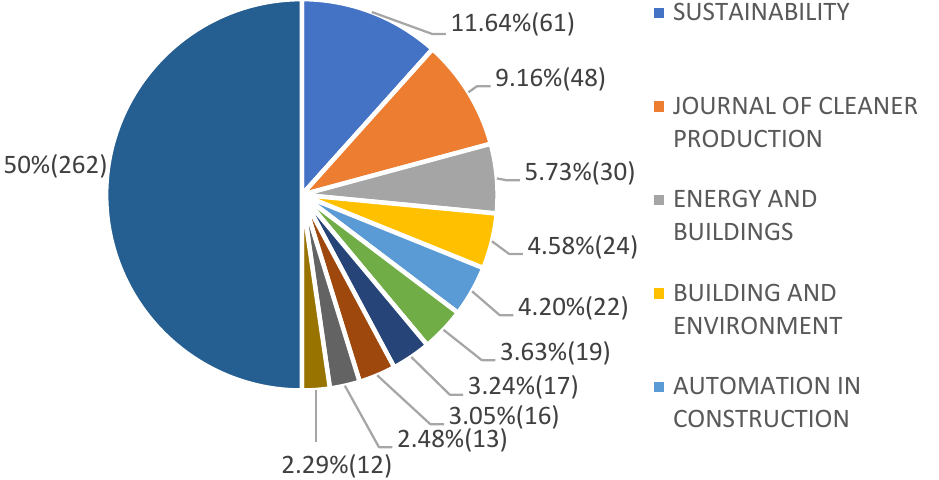
Figure 3. Sources of published articles regarding BIM on carbon emissions for sustainable buildings from 2008 to 2021 (14 years) in WoS (generated by the authors).